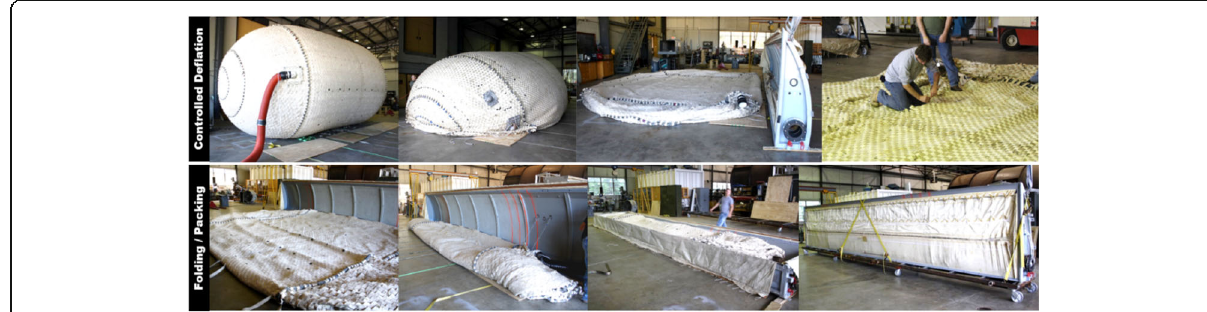
Fig. 13. For each one of these tests, two complementary methods were used to measure the conformity of the plug to the tunnel contours: A) a visual scoring/rating system, and B) sensor strips installed on the floor, ceil- ing, and walls of the tunnel to measure plug contact (see Fig. 11). A key feature to significantly increase the con- passive restraining devices (i.e., break cords) during the folding process (see Fig. 9). These passive restraining de-